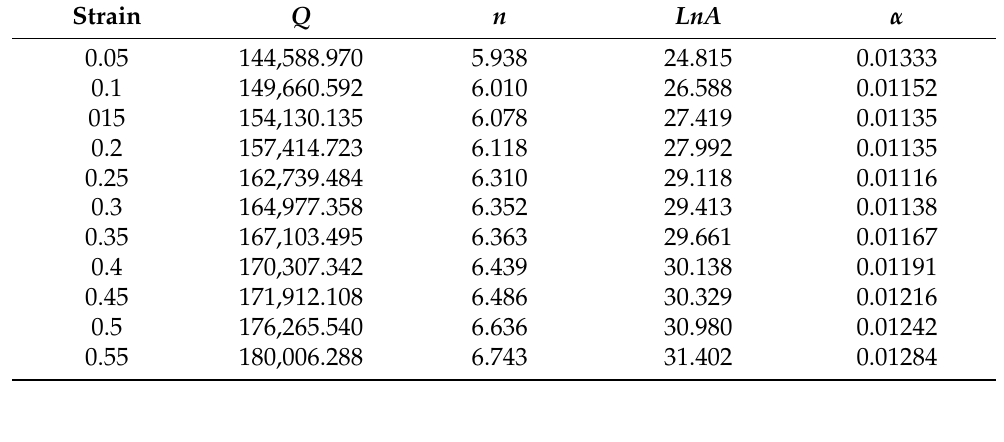
Table 5. The variation rule of each parameter with strain is shown in Figure 10. Table 5. The model parameter values under different strain conditions.